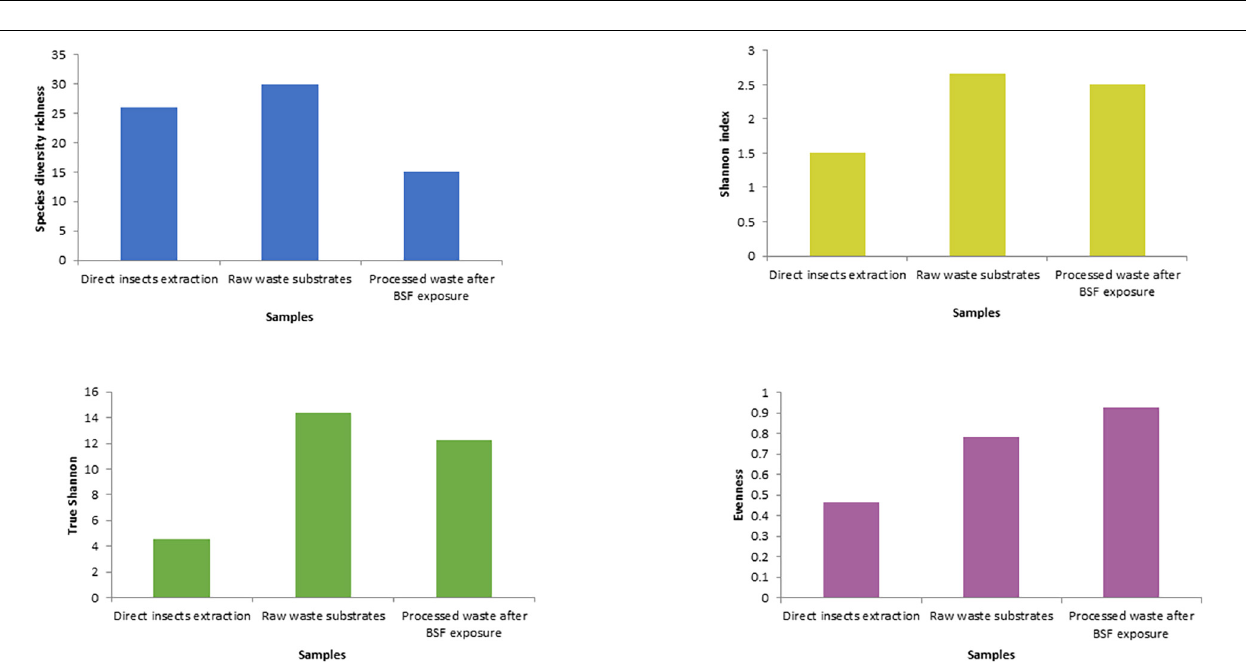
FIGURE 4 | Taxonomic composition and percentage of reads of bacteria at the genus level, in the black soldier fly larvae (BSFL) and its substrates, using Stacked Bar plot. For clarity, taxa with cumulative read counts below the cut-off value of 0.1% were summed into “Others” category.